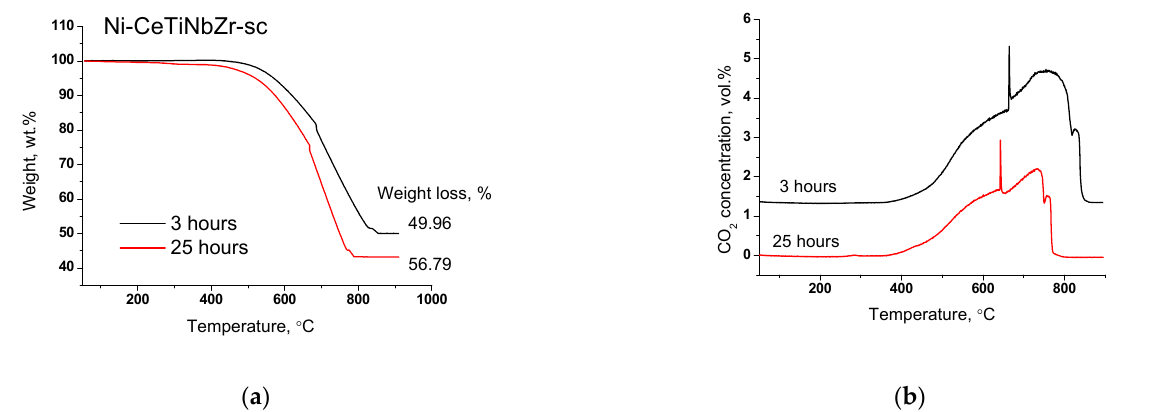
Figure 13. Weight loss ( a ) and CO 2 concentration ( b ) during TGA of Ni-CeTiNbZr-sc after long-term stability tests for 25 and 3 h in methane dry reforming.